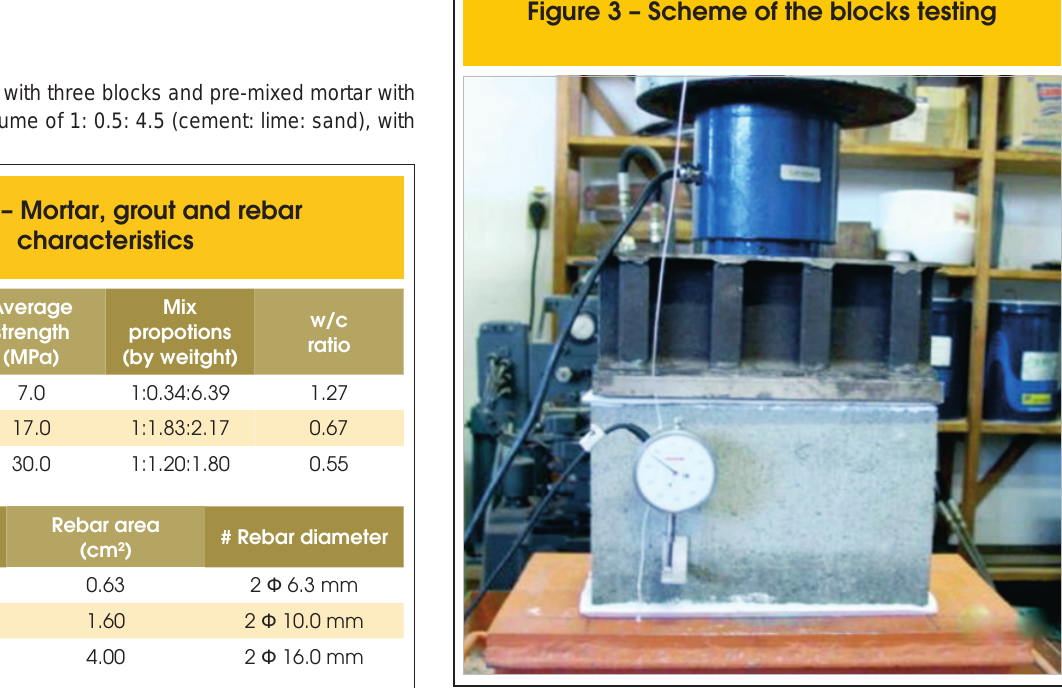
Figure 3 – Scheme of the blocks